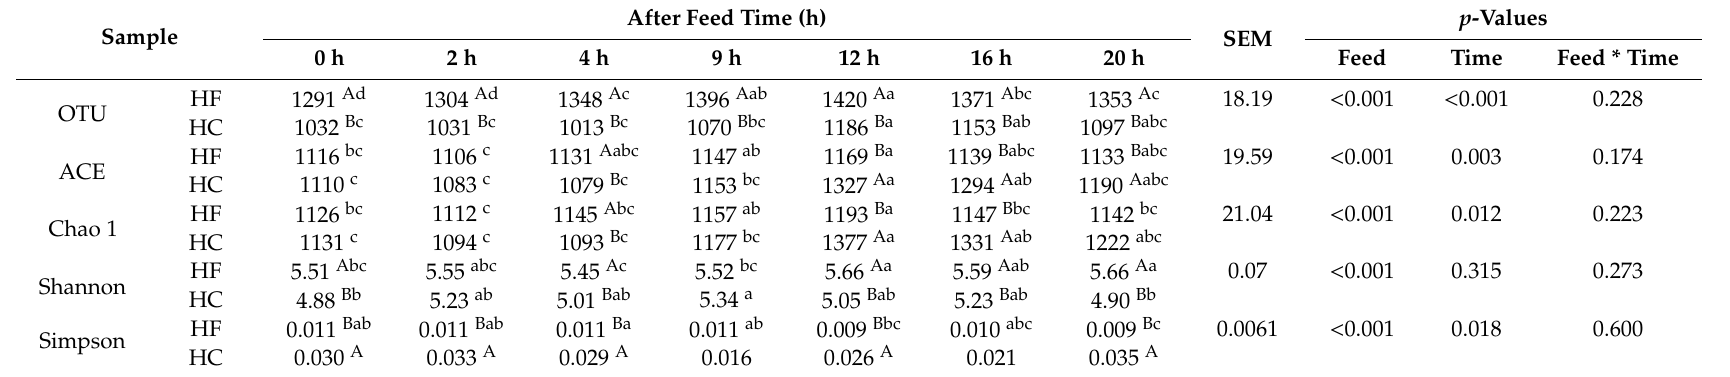
Table 3. Alpha-diversity indices in the rumen microbiota of dairy cows receiving two diets: HF and HC 1 . Sample